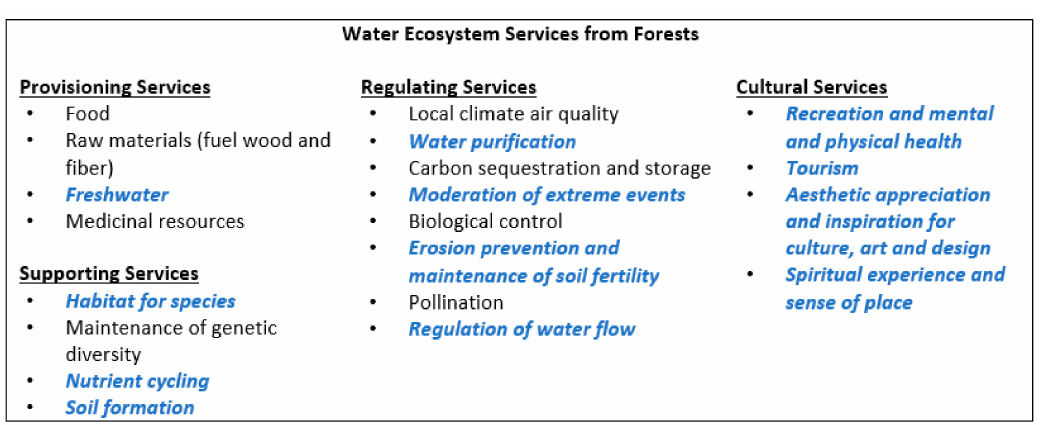
Figure1. Waterecosystemservicesprovidedbyforests.AdaptedfromMilleniumEcosystemAssessment (MEA) (2005)